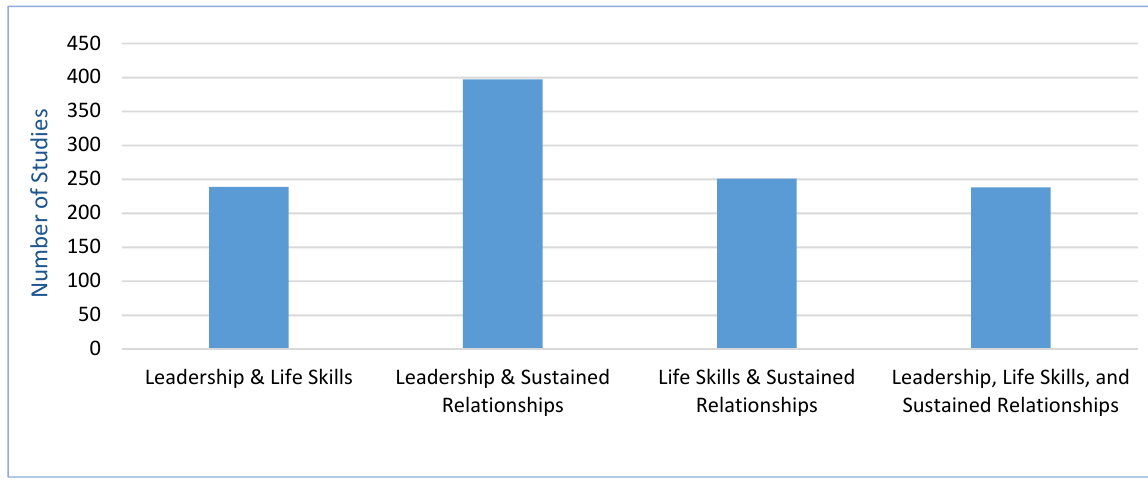
Figure 3. Studies that Address Combinations of PYD Principles